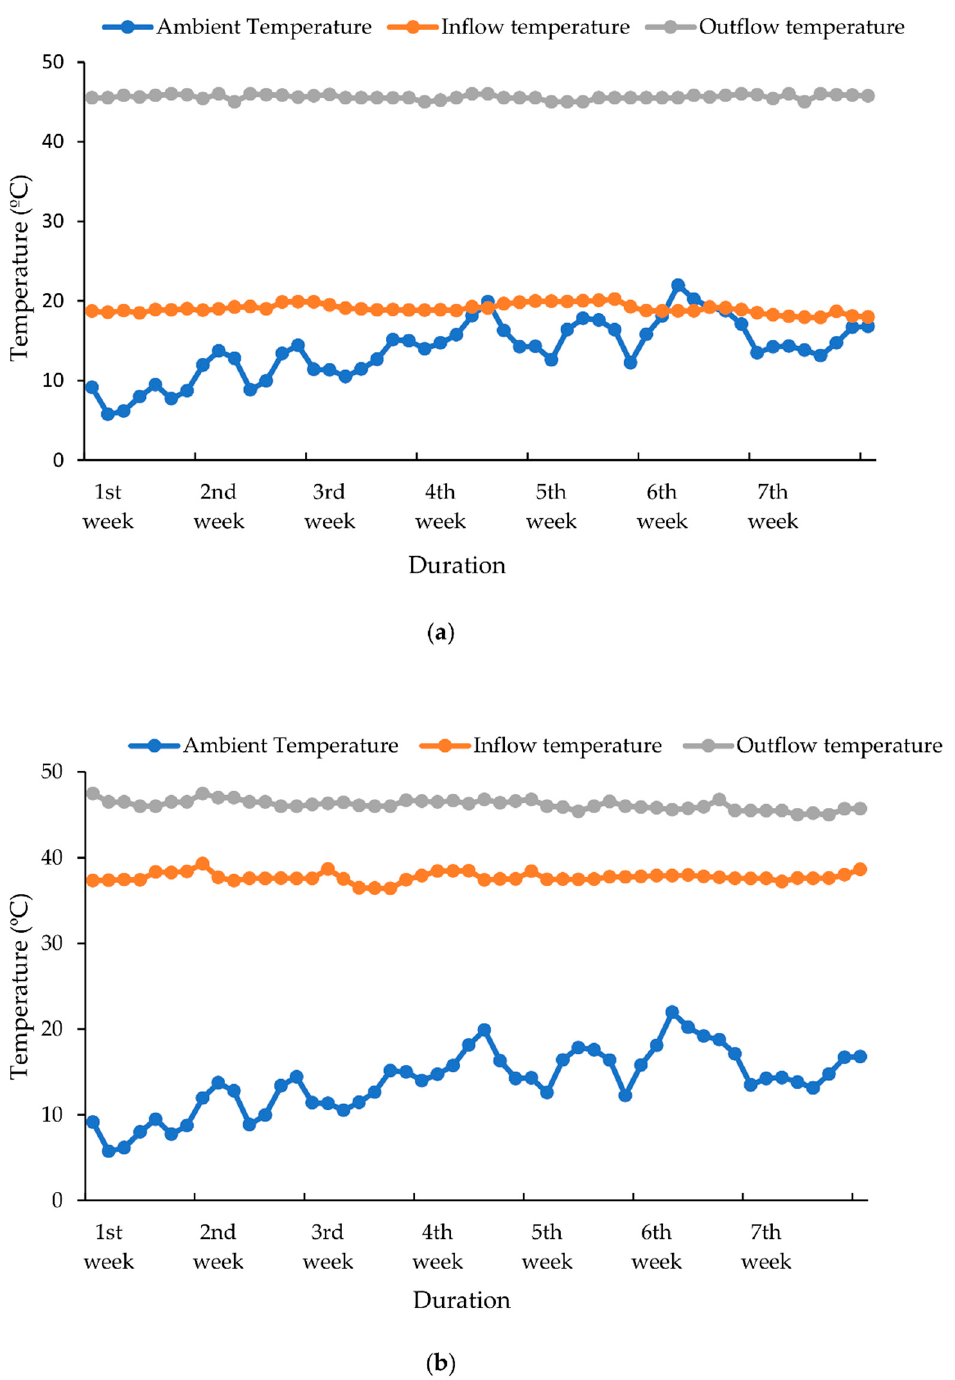
Figure 5. Outflow and Inflow temperature ( a ) GHP outflow and inflow temperature. ( b ) Solar collector outflow and inflow temperature.